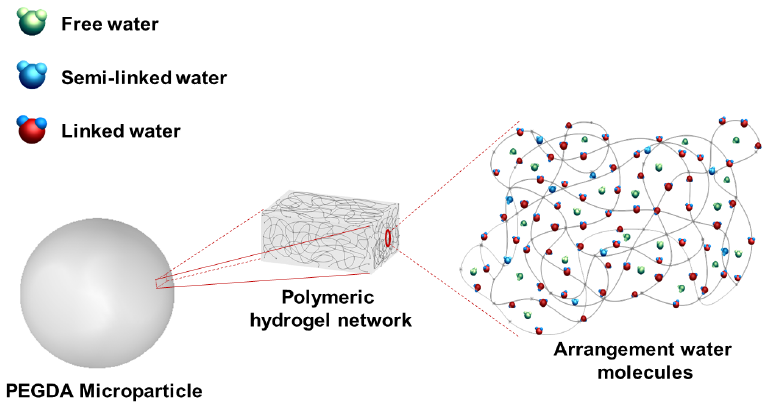
Figure 12. The three physical states of water in a polymer network are shown within the polymeric network of the